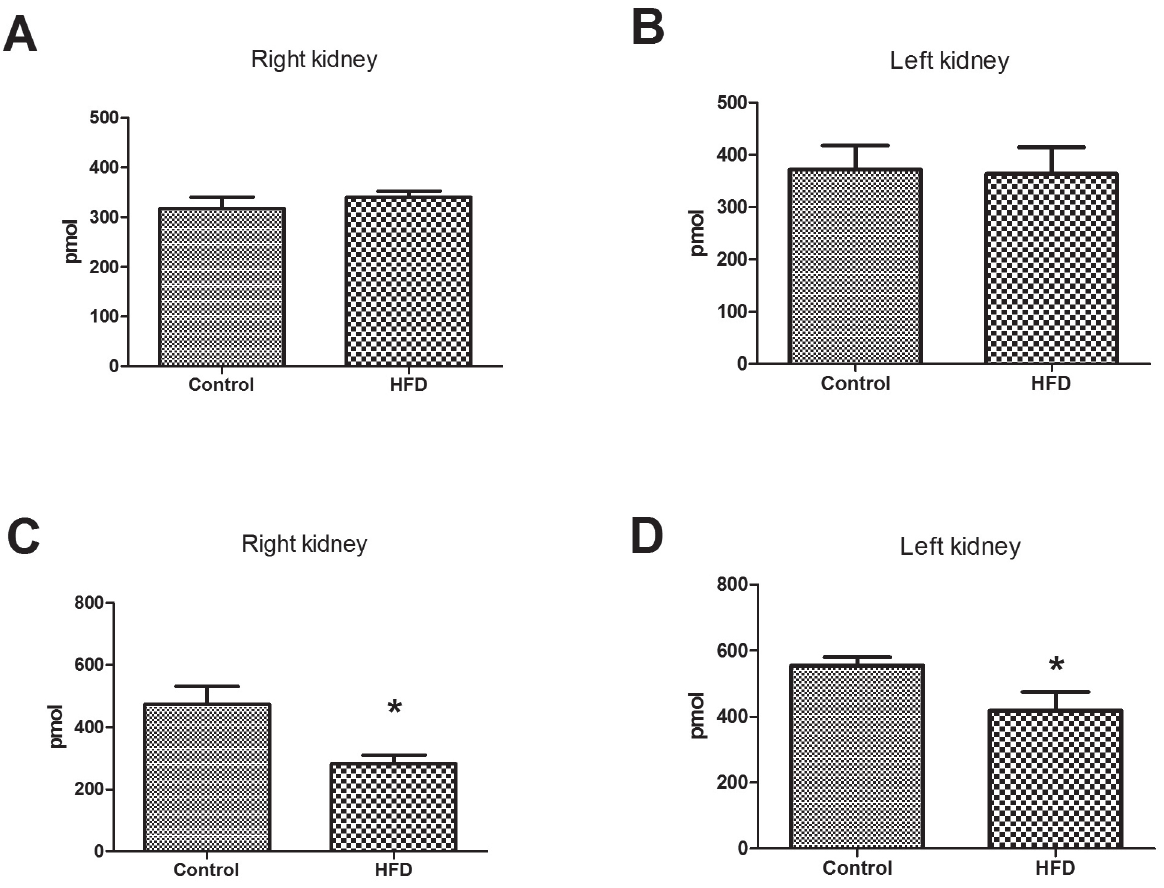
FIGURE 6 - Total lipid profile of kidney of mice fed with high fat diet. Total phospholipids (A, B) and cholesterol (C, D) were measured from kidney membrane preparation. The experiments were performed in triplicate. * represent p<0.05) of t test